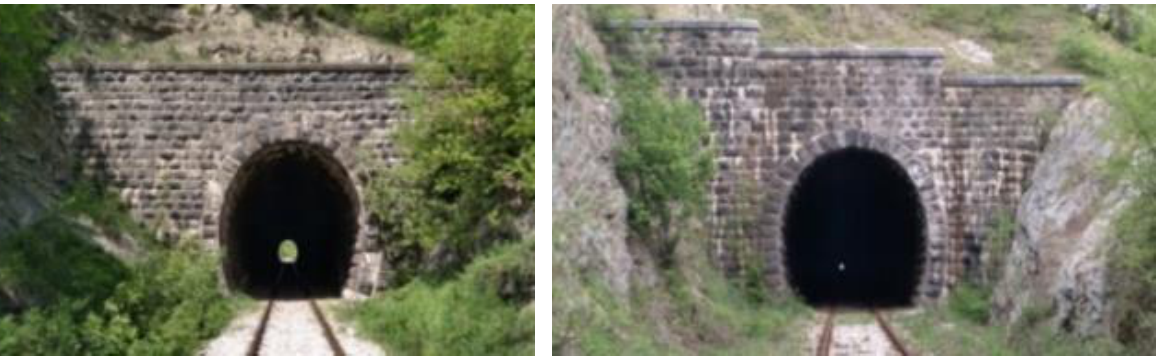
Figure 3. Tunnels